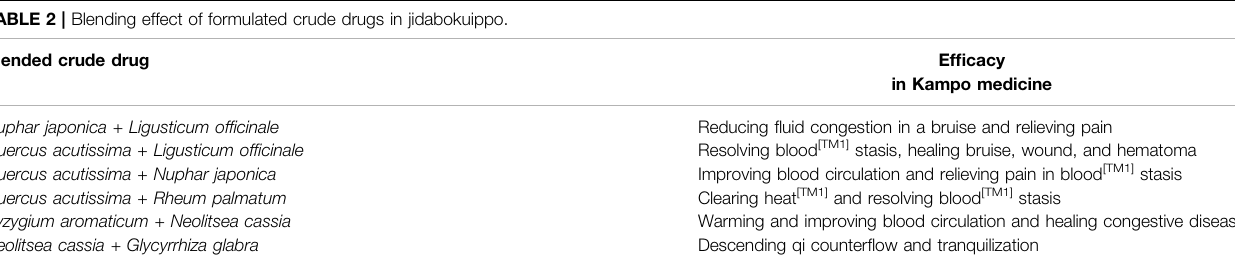
TABLE 2 | Blending effect of formulated crude drugs in jidabokuippo. Blended crude